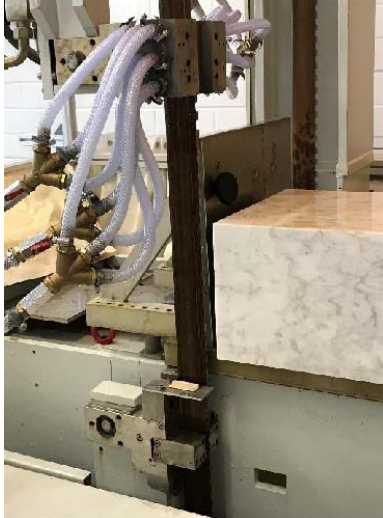
Figure 7. Bandsaw with upper hydrostatic guides and lower bearing